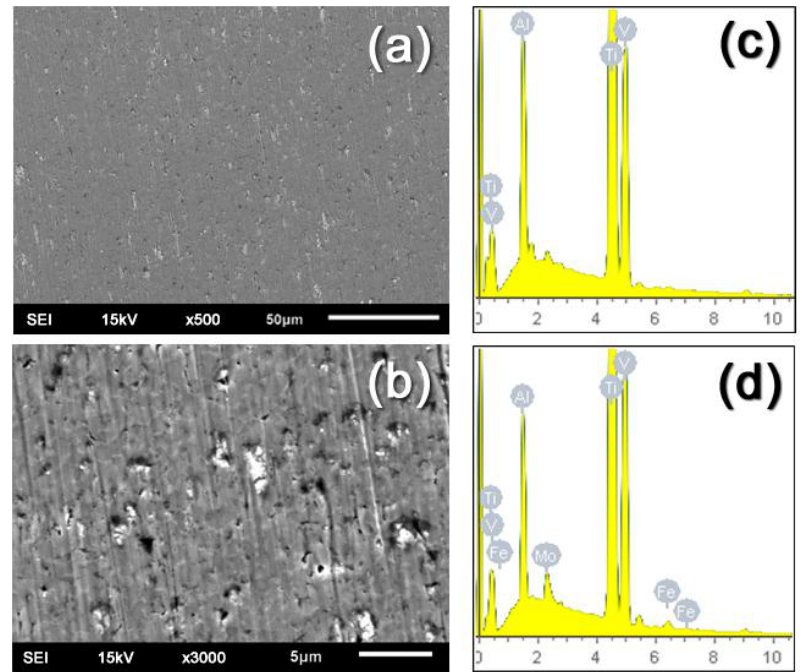
Figure 11. SEM/EDX for the as-annealed Ti-54M sample at 800 °C and after five days of immersion in 2 M HCl solutions, ( a ) and ( b ) are the SEM images; ( c ) and ( d ) are the EDX profiles for the area shown in ( a ) and ( b ), respectively.